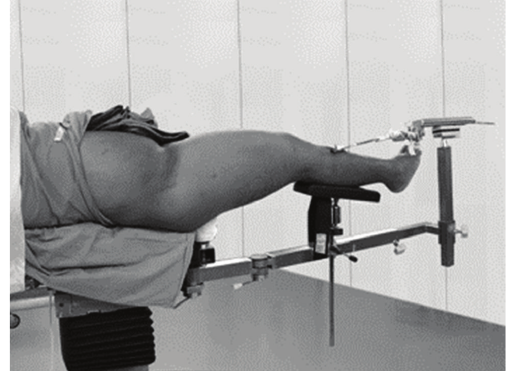
Figure 2: The picture shows patient positioning on a fracture operating table with a skeletal traction applied at the proximal tibia.